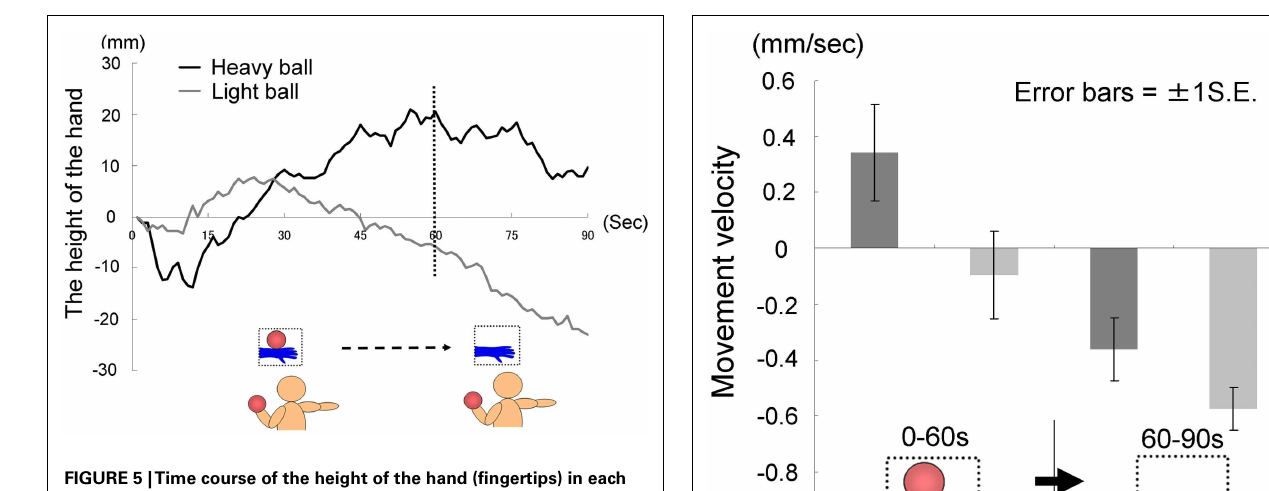
body parts were recorded: shoulder, elbow, wrist, and tip of the middle finger.